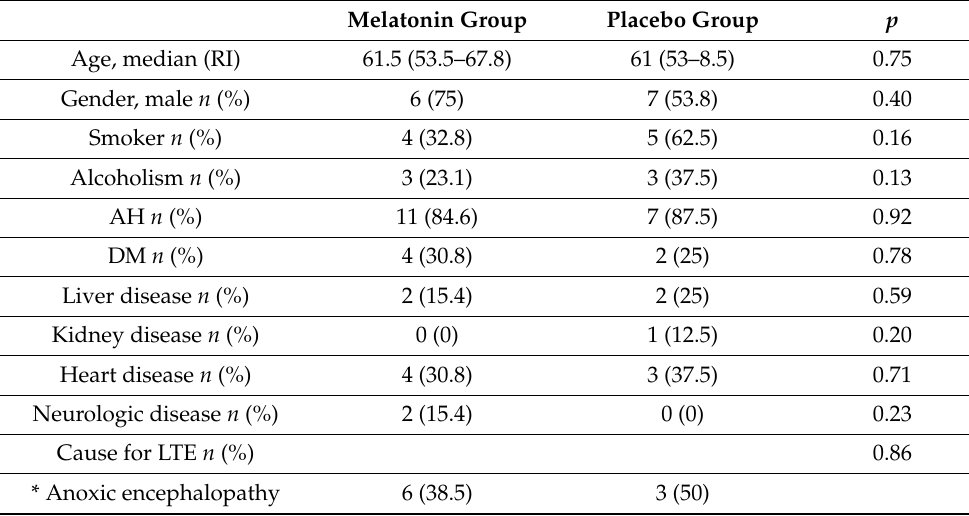
Table 2. Clinical variables of the donation after cardiac death